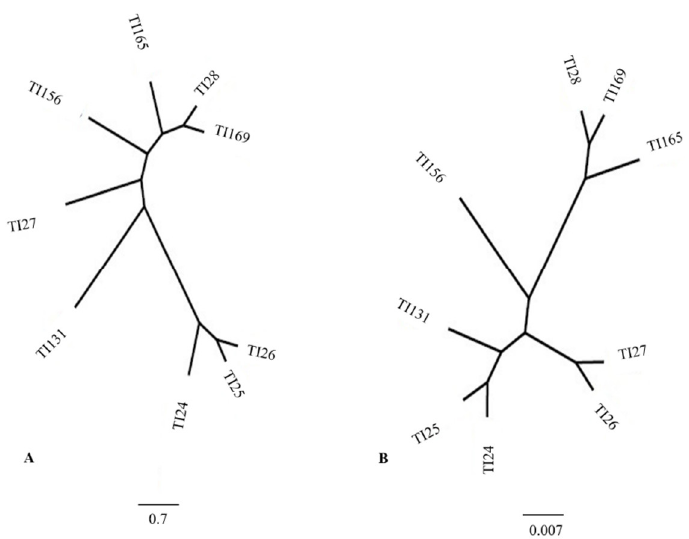
Figure 4. Dendrograms generated after generalized Procrustes analysis among populations from different localities. ( A ) Dendograma of the distance Mahalanobis ( B ) Dendograma of the distance Procrustes. TI24 (Guarani das Missões/RS/BR); TI25 (Argentina/Cordoba); TI26 (Argentina/Sta. Fe); TI27 (Entre Ijuís/RS/BR); TI28 (Sto. Cristo/RS/BR); TI131 (Sta. Rosa/RS/BR); TI156 (Sta. Rosa/Residual foci/RS/BR); TI165 (Cochabamba/Bolívia); TI169 (Tremedal/Residual foci/BA). BR-BRAZIL, RS-Rio Grande do Sul.